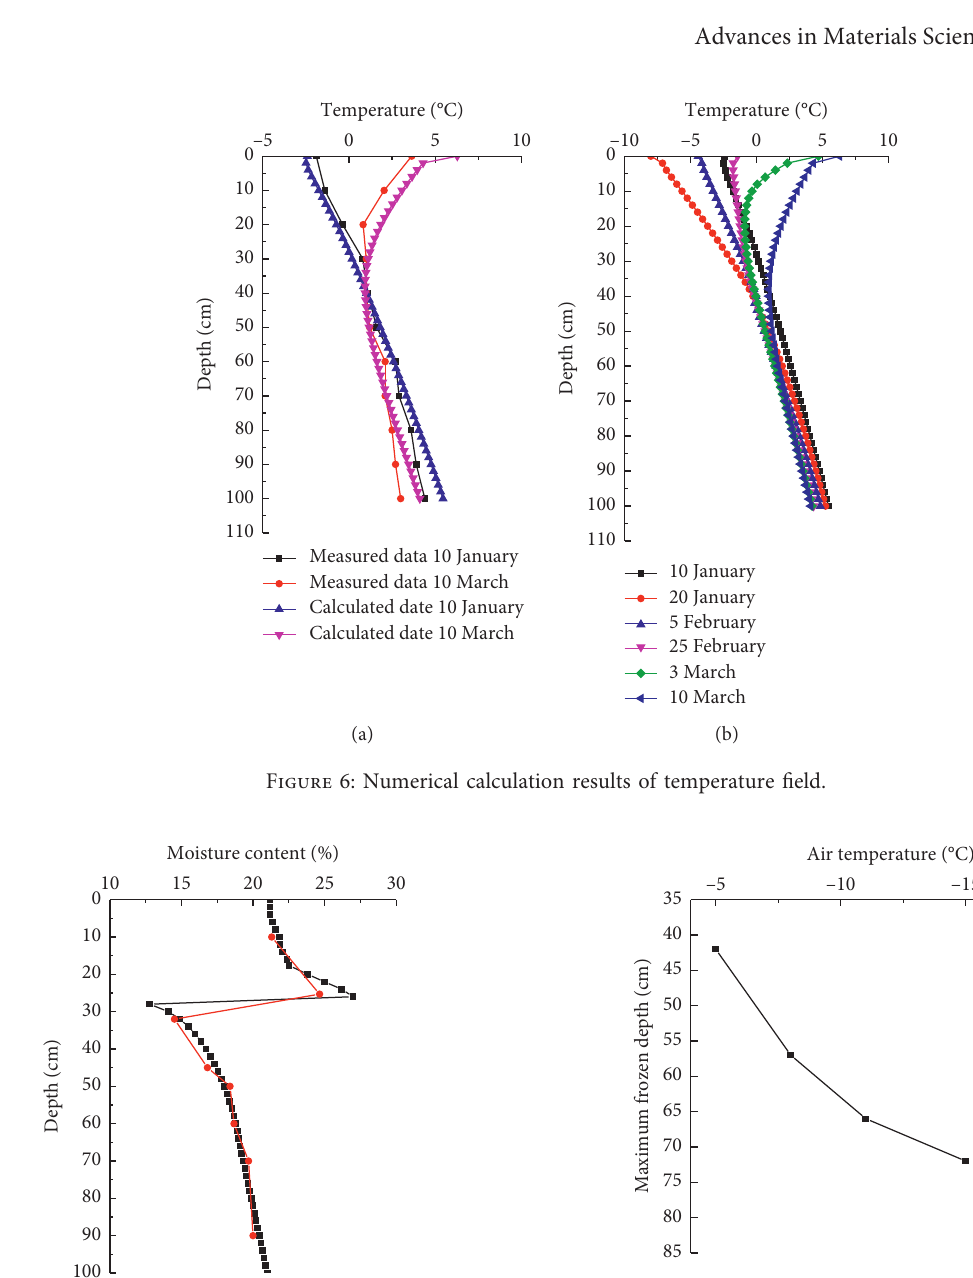
Figure 8: The relationship between the temperature and the maximum frozen